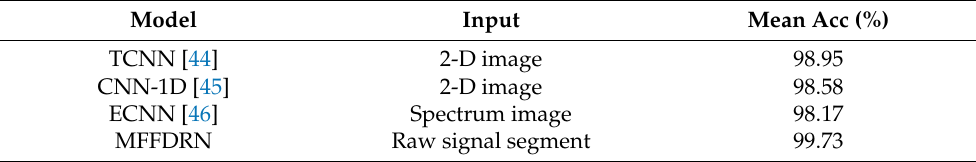
Table 5. Comparison of MFFDRN with some advanced methods in Case 1.